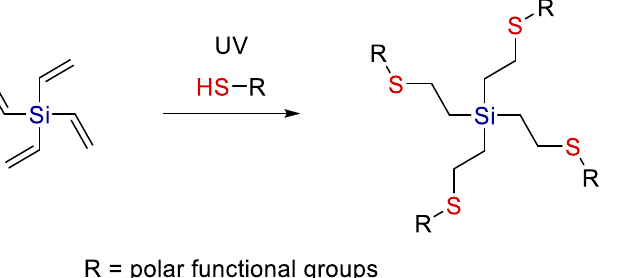
Figure 10. A scheme of modification of a tetrafunctional silane by thiol-ene addition [26]. Ref.